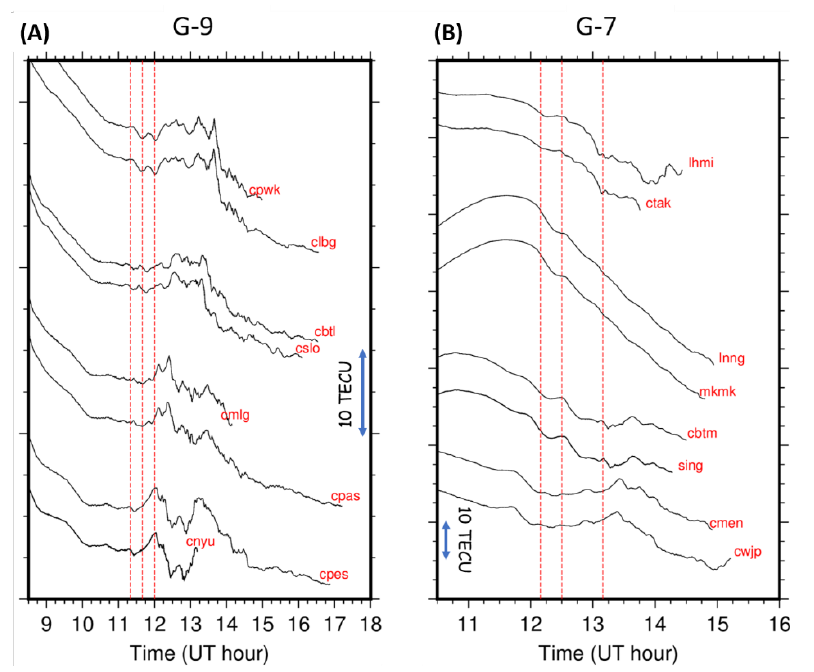
green dots on maps at the times marked by black and green dashed lines on the GNSS-TEC time series. Blue curves are low-degree best-fit polynomials of the VTEC data with the exclusion window (data within this window are not used to estimate the polynomials) between dashed lines.